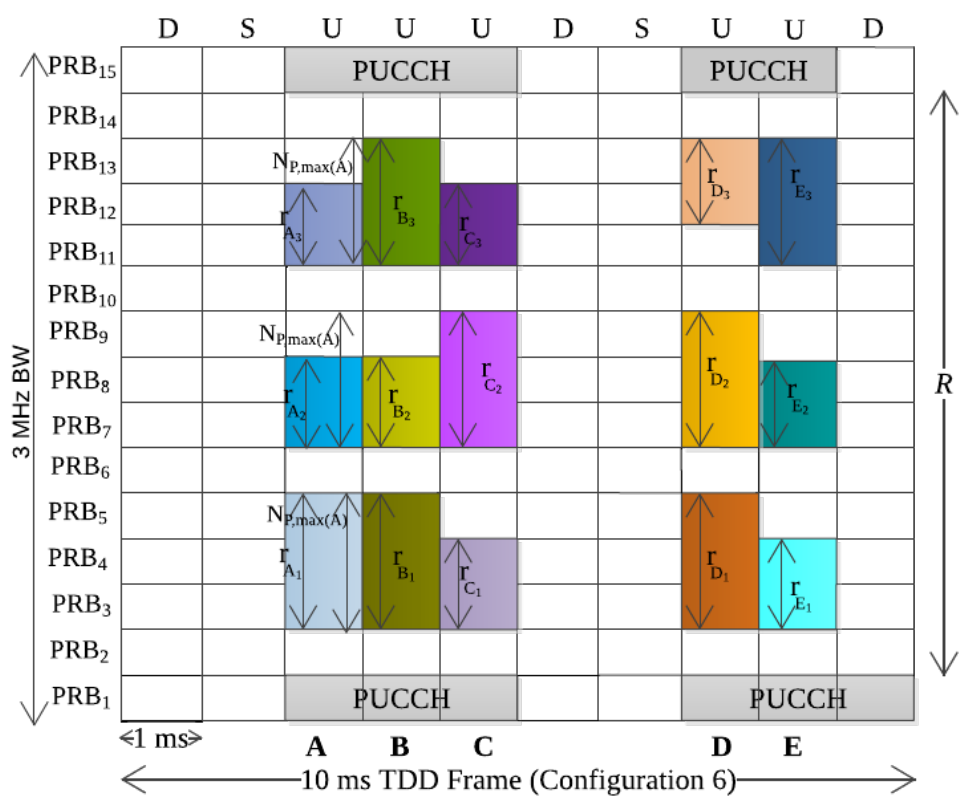
Figure 1. Multi-service traffic classes allocated in different uplink